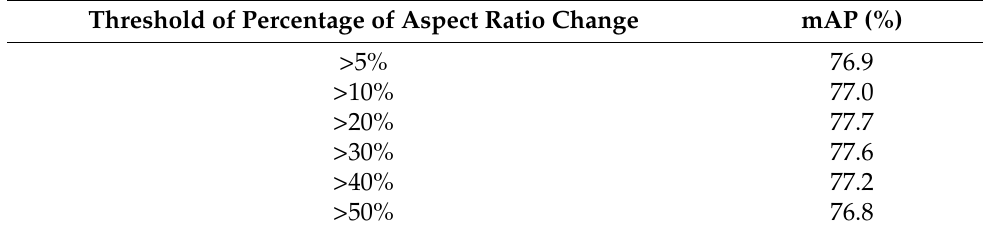
Table 3. Performance comparison using various thresholds for the percentage of aspect ratio